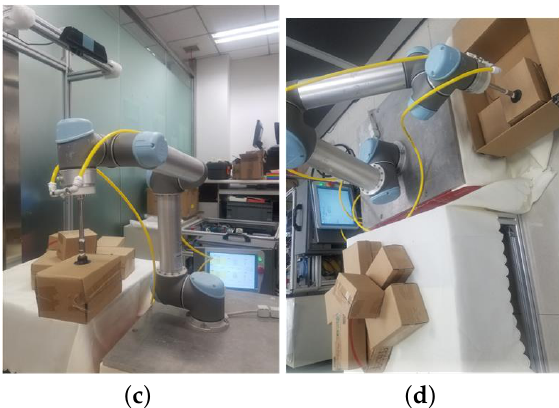
Figure 14. Robot sorting experiment. ( a ) Grasping. ( b ) Picking up. ( c ) Moving. ( d )